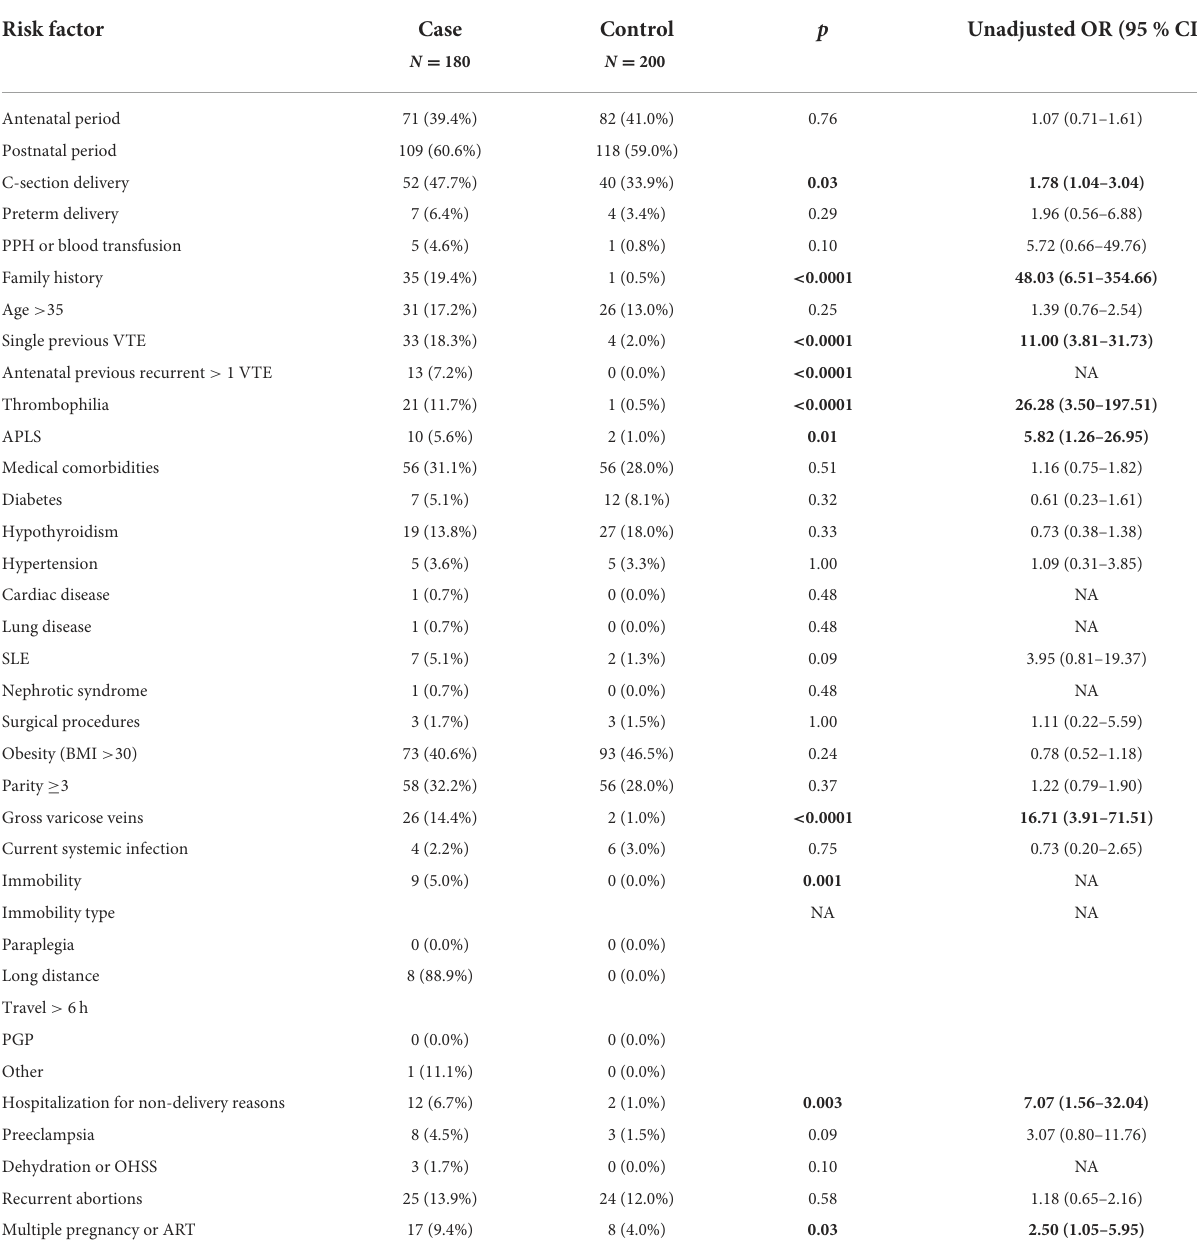
TABLE 2 Association between different risk factors and VTE in cases and